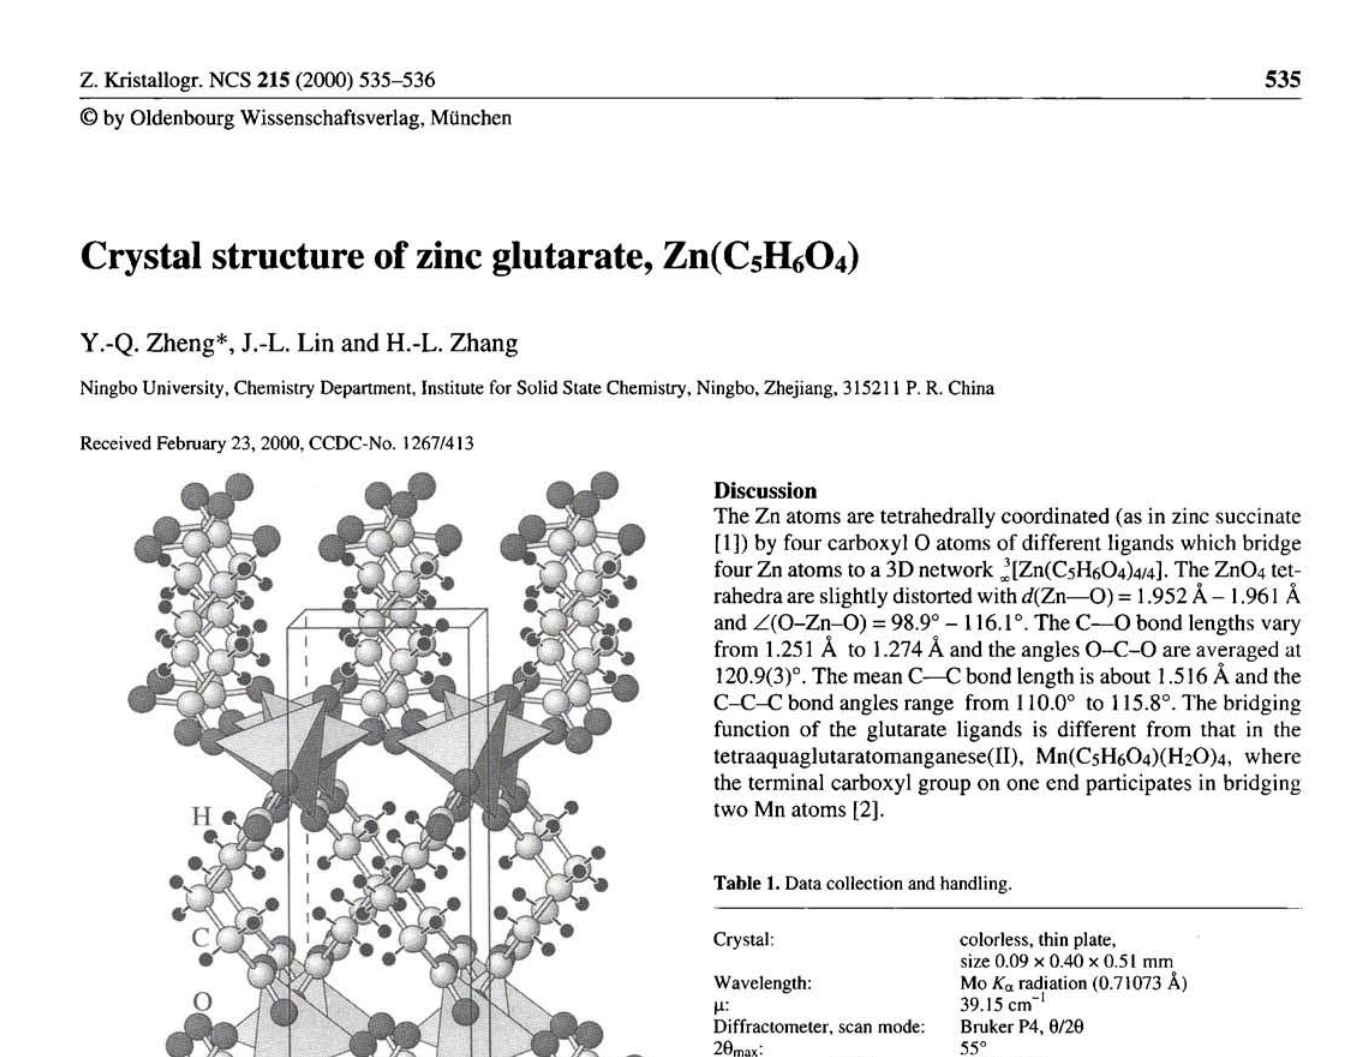
Table 2. Atomic coordinates and displacement parameters (in